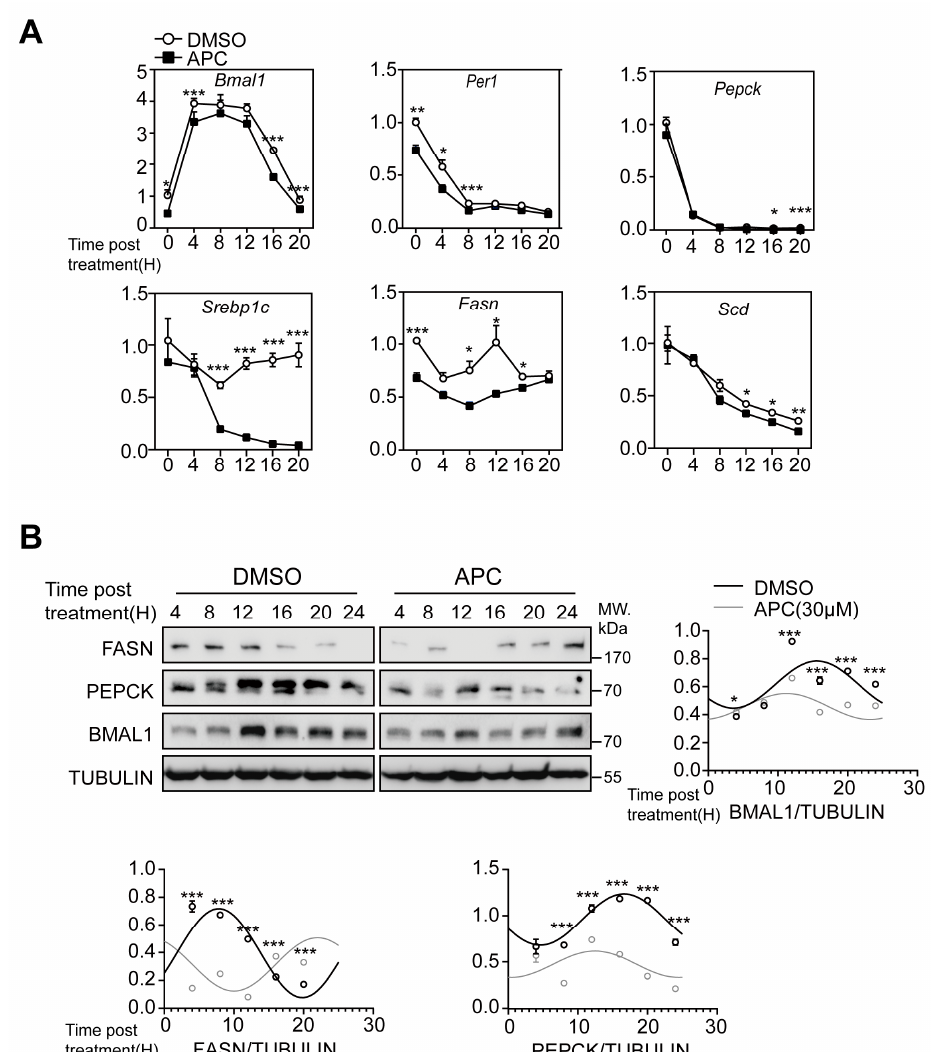
Figure 3. Temporal analysis of hepatic genes expression following APC administration: ( A ) the mRNA levels of the indicated genes analyzed in primary hepatocytes; mouse primary hepatocytes were synchronized by dexamethasone (1 µ mol/L) for 2 h and then treated with APC for 1 h prior to 4 h stimulation with glucagon (100 nM, n = 3 per group); ( B ) representative Western blots of FASN, PEPCK, BMAL1, and TUBULIN proteins in cells as treated in ( A ). For each sample, the lysates from three replicate wells of primary hepatocytes were pooled together for immunoblot assays. We calculated the means of corresponding densitometry of BMAL1, PEPCK, and FASN protein, and they were superimposed with corresponding sine fittings generated by cosinor analyses. The black circles represent the means of corresponding densitometry of protein in the DMSO group and the grey circles represent the APC group. * p < 0.05; ** p < 0.01; *** p <